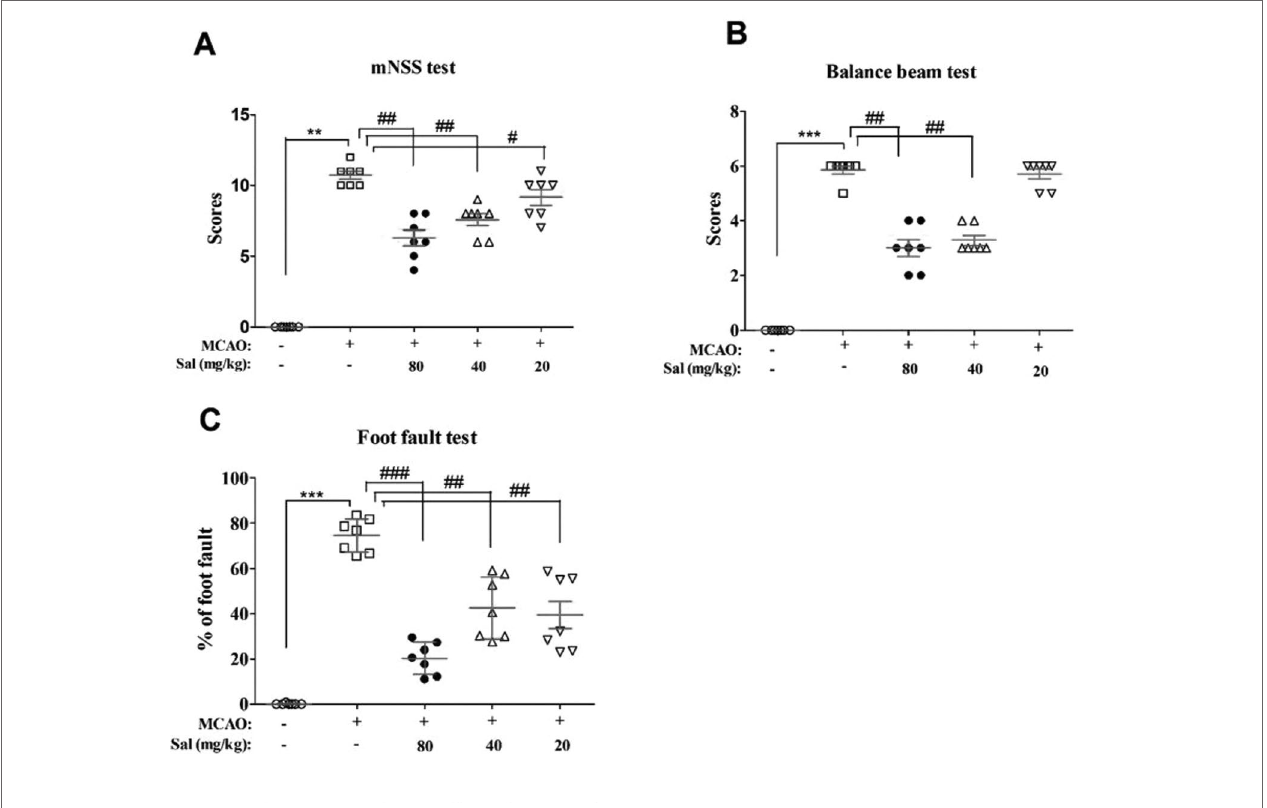
FIgURE 4 | Salidroside improves neurobehavioral impairment after MCAO. Rats that were treated with 80, 40, and 20 mg/kg salidroside or saline water prior to MCAO exhibited significant change in the mNSS test (a) , balance beam test (B) , and foot fault test (C) . Data are expressed as the mean ± SEM, n = 7. ** p < 0.01, *** p < 0.001 compared to the sham group; # p < 0.05, ## p < 0.01, ### p < 0.001 compared to the MCAO group. MCAO middle cerebral artery occlusion, mNSS modified neurological severity score, SEM standard error of the mean.